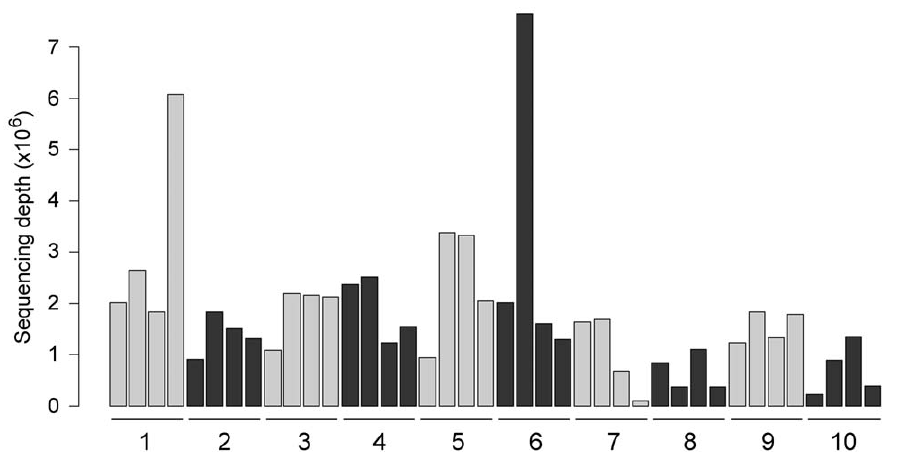
Figure 2. Histogram showing the number of sequences aligned for each of the 40 experimental samples (sequencing depth). Numbers represent individual donors and the 4 bars from each donor correspond to untreated control, and pterygium cells treated for 24 h with 50, 200, and 500 m g/ml doxycycline (left to right). There is a large variation in sequencing depth ranging from 82,040 reads for the less represented (cells from patient number 7, treated with 500 m g/ml doxycycline) to 7,653,010 reads for the best represented (cells from patient number 6, treated